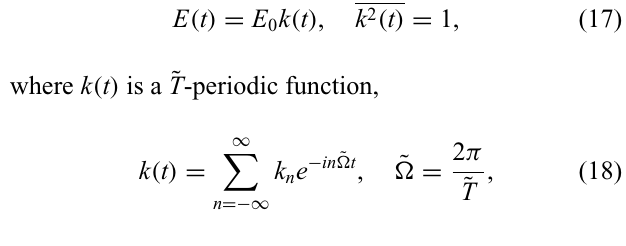
FIG. 2. Basic principle behind the universal frequency con- version technique as exemplified by two-tone probing (lower part) and juxtaposed with the case of conventional single-tone driving (upper part). These schemes for coupling an oscillator to a traveling light field are illustrated by their individual out- put spectra; the two-photon (homodyne) phase quadrature results from folding the spectrum around the local oscillator fre- quency ω LO, j = ω o , j . (top) Single-tone coupling of an oscillator with eigenfrequency (cid:2) 1 using a tone at ω o ,1 (solid line); the side- bands peak at frequencies of approximately ω o ,1 ± (cid:2) 1 (true in the high- Q limit, | (cid:2) j | /( 2 γ j ) (cid:11) 1; sideband widths are exagger- ated in the figure for illustrative purposes). (bottom) Two-tone coupling scheme using coherent tones at ω o ,2 ± ˜ (cid:2) (solid lines) with mean frequency ω o ,2 (dashed line), resulting in the effec- tive oscillator evolution frequency (cid:2) 2,eff ≡ (cid:7) sign (cid:2) 2 = ( | (cid:2) 2 | − ˜ (cid:2)) sign (cid:2) 2 . The curved arrows indicate the sidebands generated by the respective drive tones in the particularly interesting case ˜ (cid:2) > | (cid:2) | ⇔ (cid:7) < 0, where the sign of the evolution frequency is 2 flipped in the down-conversion process, sign (cid:2) 2,eff = − sign (cid:2) 2 . This reflects the circumstance that, for ˜ (cid:2) > | (cid:2) 2 | , the upper (lower) central sideband arises as the lower (upper) sideband of the originating drive tone. If a joint measurement is performed on oscillators 1 and 2, broadband destructive interference between the QBA responses contained in the green, central sidebands is possible if (cid:2) 1 = − (cid:2) 2,eff